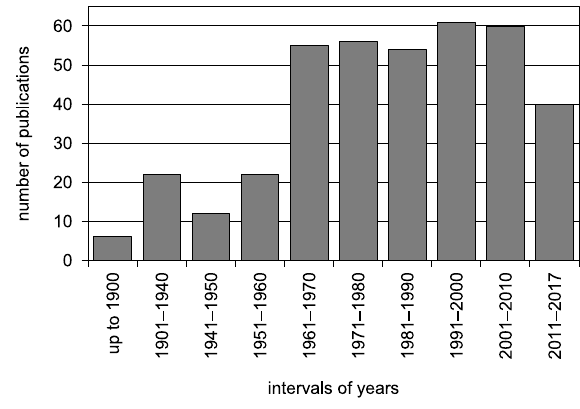
Fig. 1. Number of publications whose main subject was snow cover